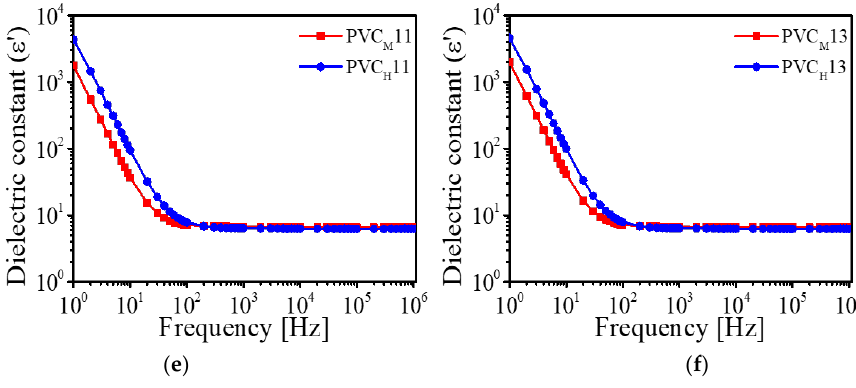
Figure 6. Experimental results for the dielectric constant of the PVC gels: different molecular weights of PVC with the weight ratio of PVC to DBA plasticizer of ( a ) 1:3, ( b ) 1:5, ( c ) 1:7, ( d ) 1:9, ( e ) 1:11, and ( f ) 1:13. We plotted the dielectric constants of the prepared PVC gels at 1 Hz (Figure 7). As shown in Figure 7, as the amount of plasticizer increases, the number of dipoles increases, and as a result, the dielectric constant also increases. Furthermore, the dielectric constant is proportional to the molecular weight of the PVC resin (Figure 6). It means that the use of PVC resin with high molecular weight makes entanglement, physical crosslinking and crystallization regions in a PVC gel increase.